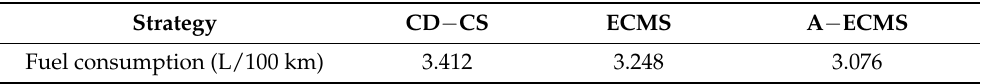
Table 4. Fuel consumption under different strategies.